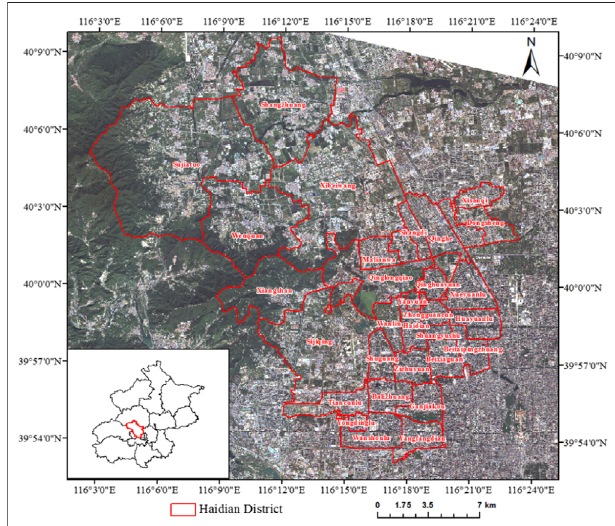
FIGURE 1 | The study area of Haidian district overlaid on a mosaicked GaoFen-2 true-color image and the location of Haidian District within Beijing, China.